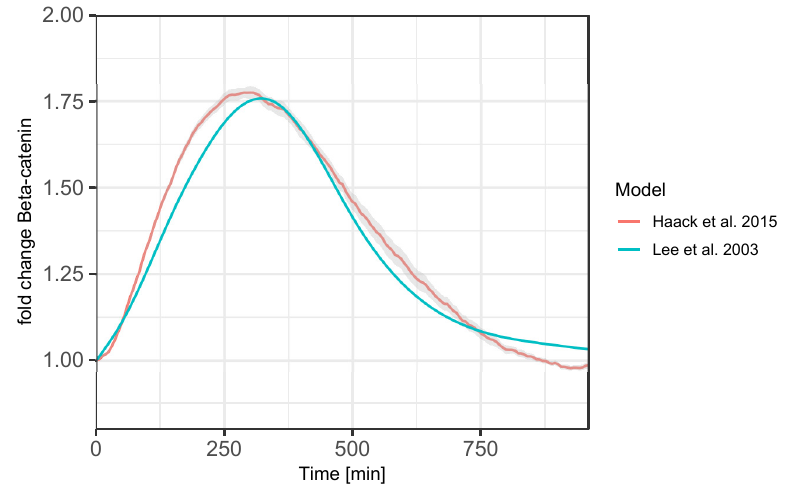
Figure 6. Results of the cross-validation of the Lee et al. model [69] and the Haack et al. model [48] (after applying a scaling factor of 0.28 to the β -catenin